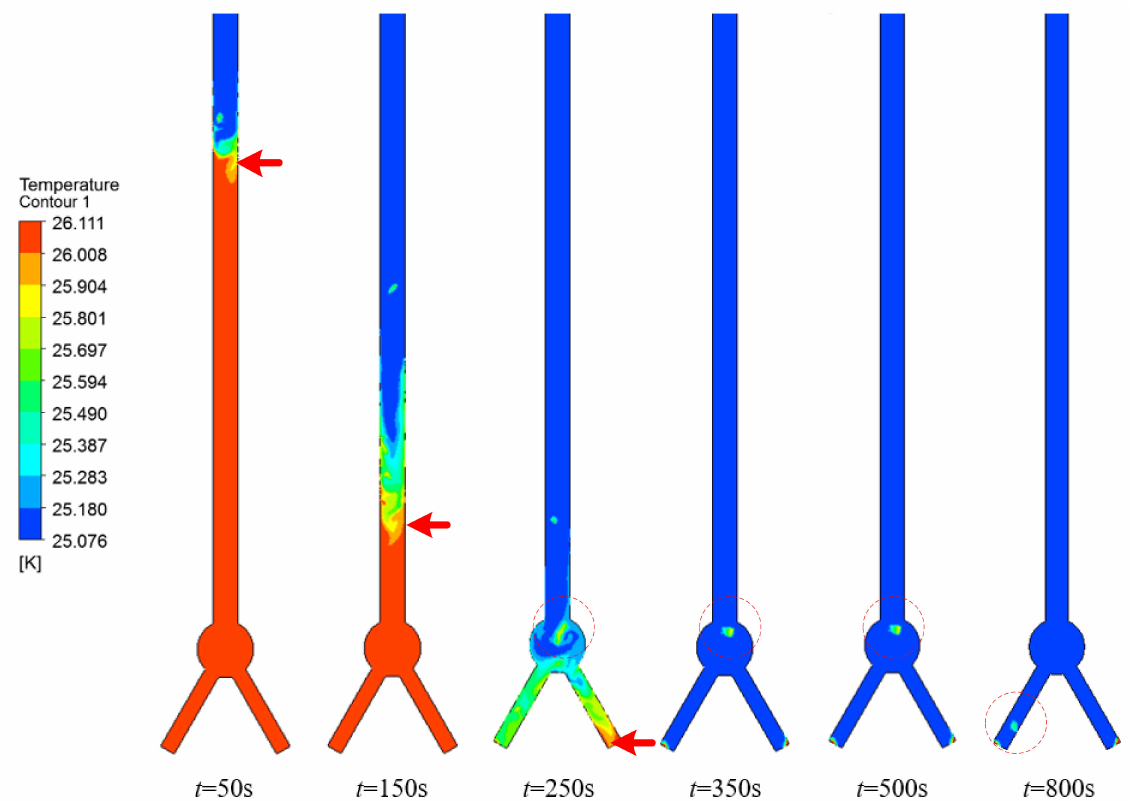
Figure 8. Temperature distribution inside delivery tube under circulation liquid flow with m = 0.2